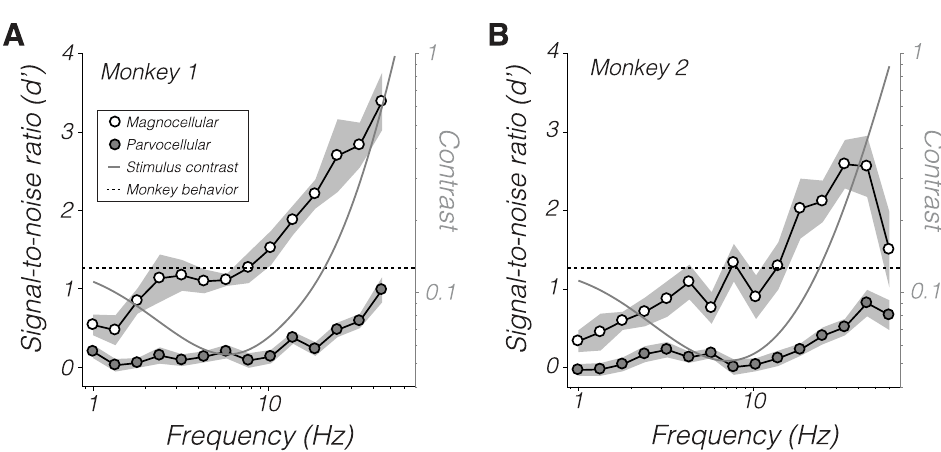
Fig 4. d 0 values of magnocellular neurons (open symbols) and parvocellular neurons (filled symbols) as a function of temporal frequency. Points are means and shaded bands are ± 1 standard error. The monkeys’ psychophysical d 0 for all stimuli is approximately 1.27 (dashed line, see Methods). Stimulus contrasts are shown for a location 5˚ out along the horizontal meridian (gray curve and right ordinate). Data are available at https://github.com/horwitzlab/LGN-